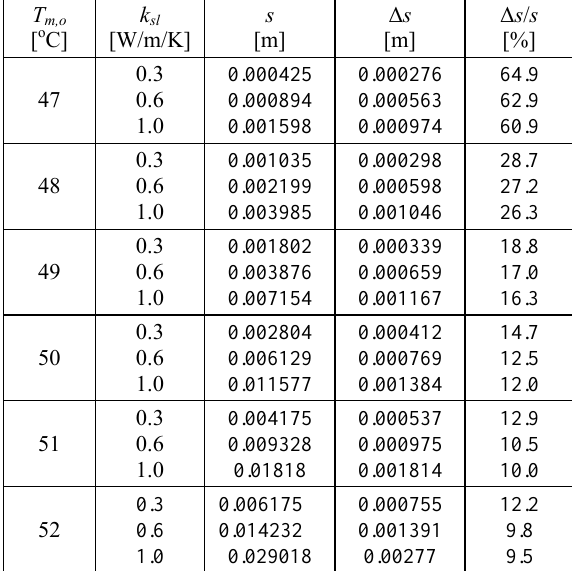
Table 2. Simulated values of the sludge thickness ( s ) and estimated uncertainties of the predictions (Δ s ) for k sl = 0.3,